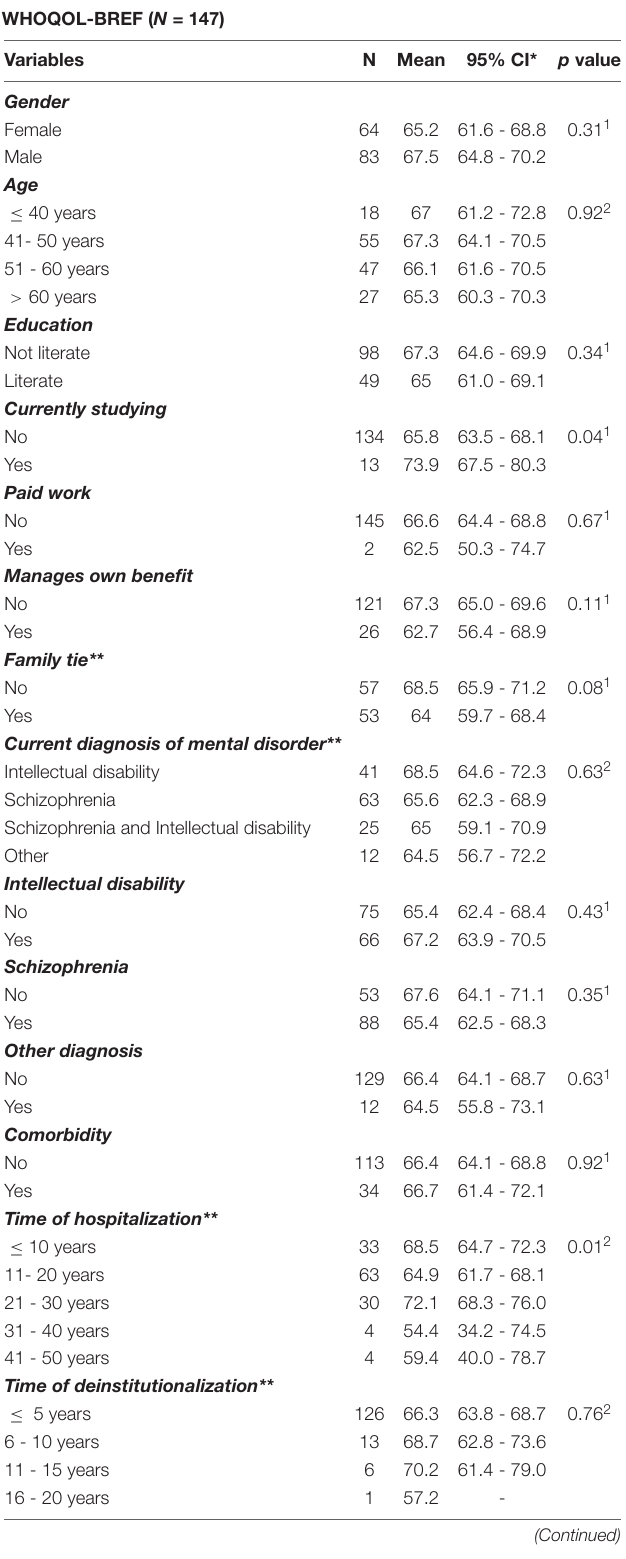
TABLE 4 | Distribution of people with mental disorders who underwent deinstitutionalization using assisted living facilities by sociodemographic and clinical characteristics according to WHOQOL-BREF, 2019, n =